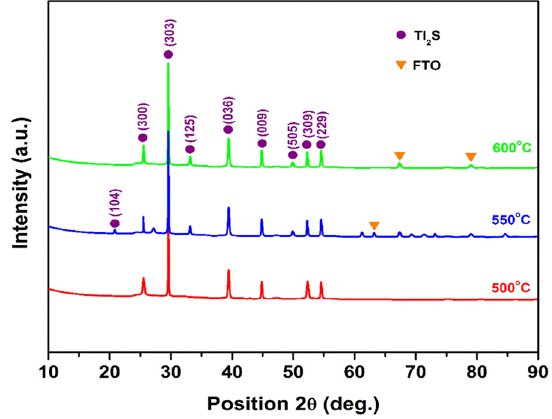
Figure 1: X - ray di ff raction ( XRD ) patterns of Tl 2 S thin fi lms deposited on the FTO substrate at three di ff erent temperatures using the AACVD